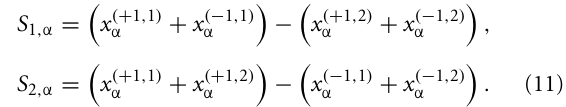
Stern-Gerlach magnet M 1 or M 2 . The magnets M 1 and M 2 , iden- tical and both with their magnetic field along direction c ,